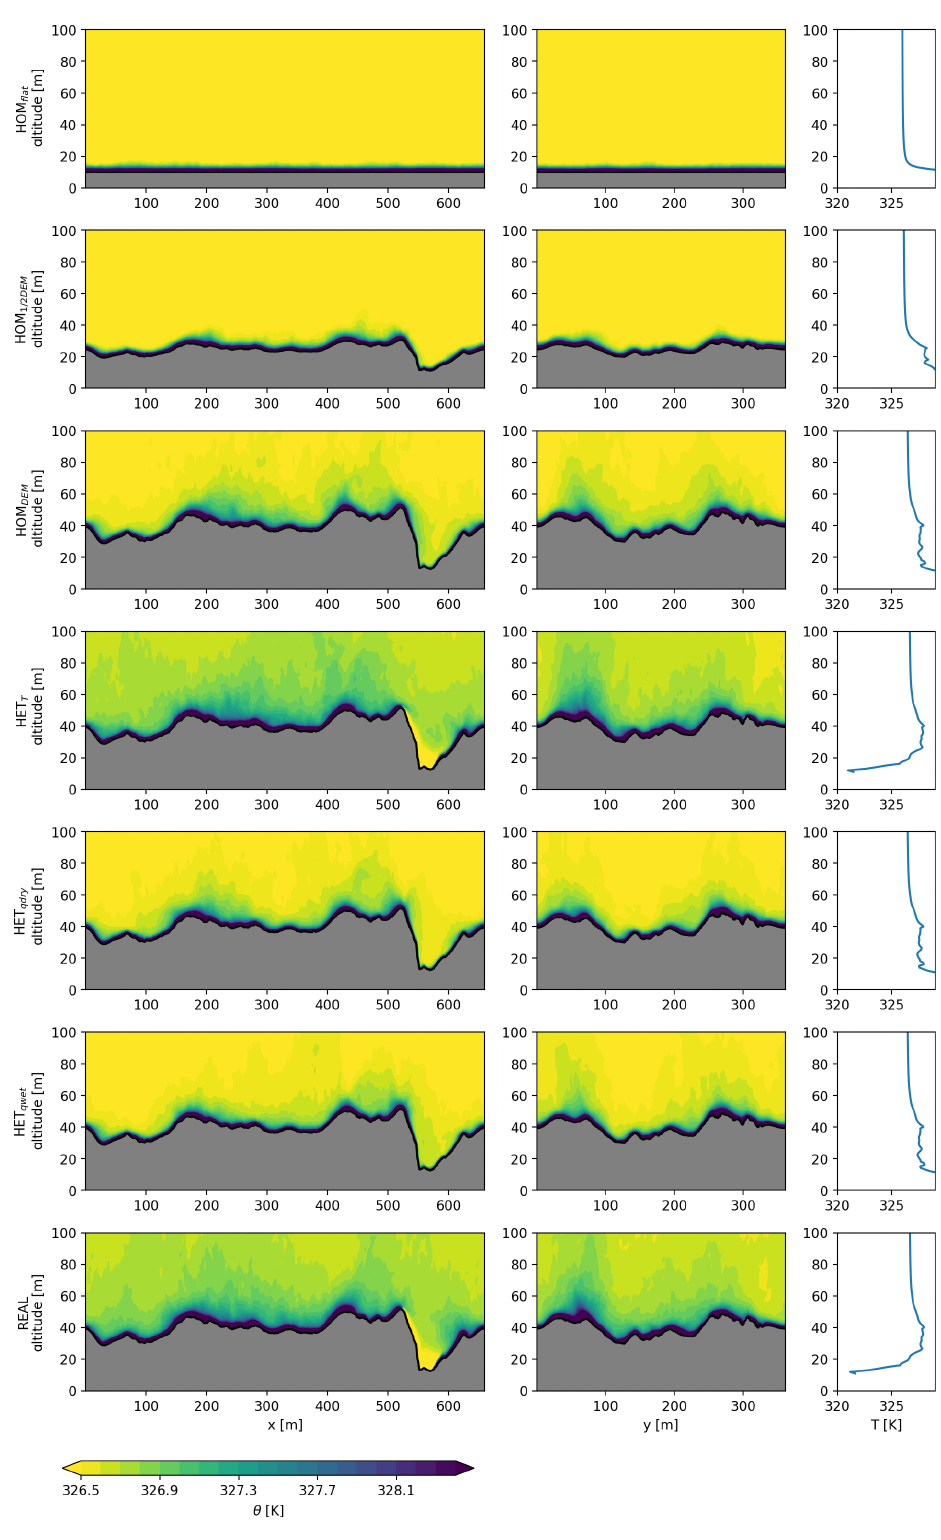
Figure 7. As in Fig. 5 but for the potential